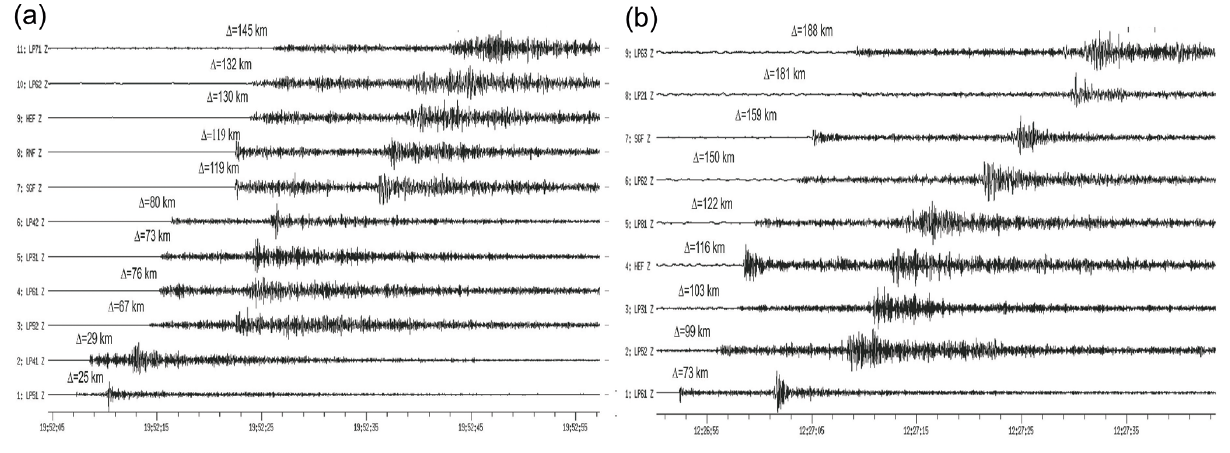
Figure 2. Examples of waveforms of local events in Z component: (a) shallow event on 19 January 2008 at 19:52UTC, 67.23 ◦ N, 23.80 ◦ E, depth = 10.4km, ML = 2.2 (FENCAT); (b) deep event on 03 October 2007 at 12:26UTC, 67.42 ◦ N, 22.81 ◦ E, depth = 27.4km, ML = 1.6 (FENCAT). Epicentral distances (cid:49) were calculated using the FENCAT catalogue. Recordings were band-pass filtered with corner frequencies at 1 and 15Hz and amplitude normalised.